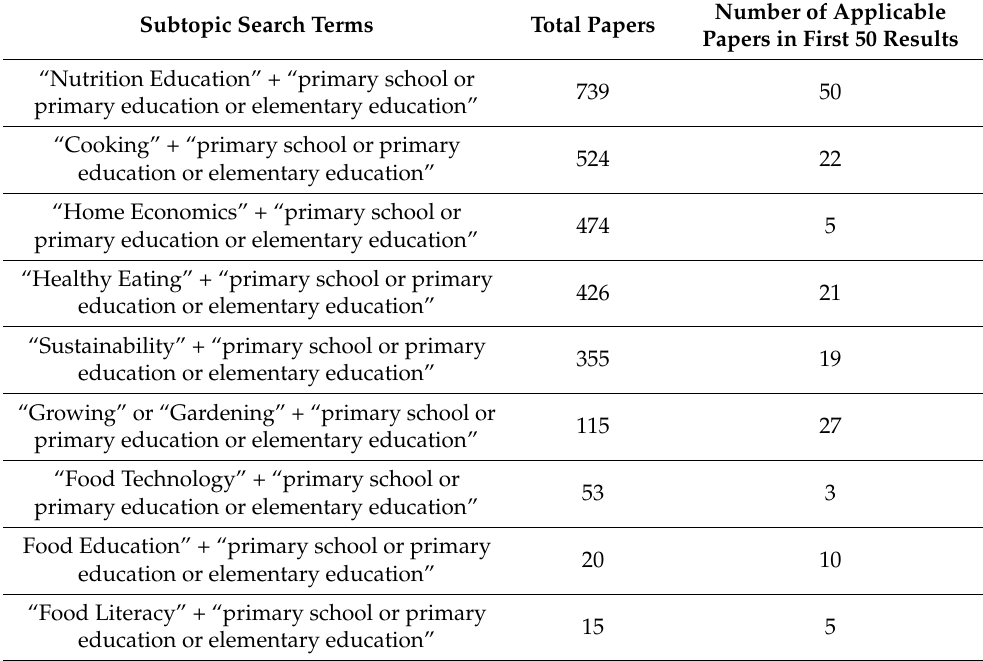
Table A1. Number of papers relating to food education in primary school. Source: authors.